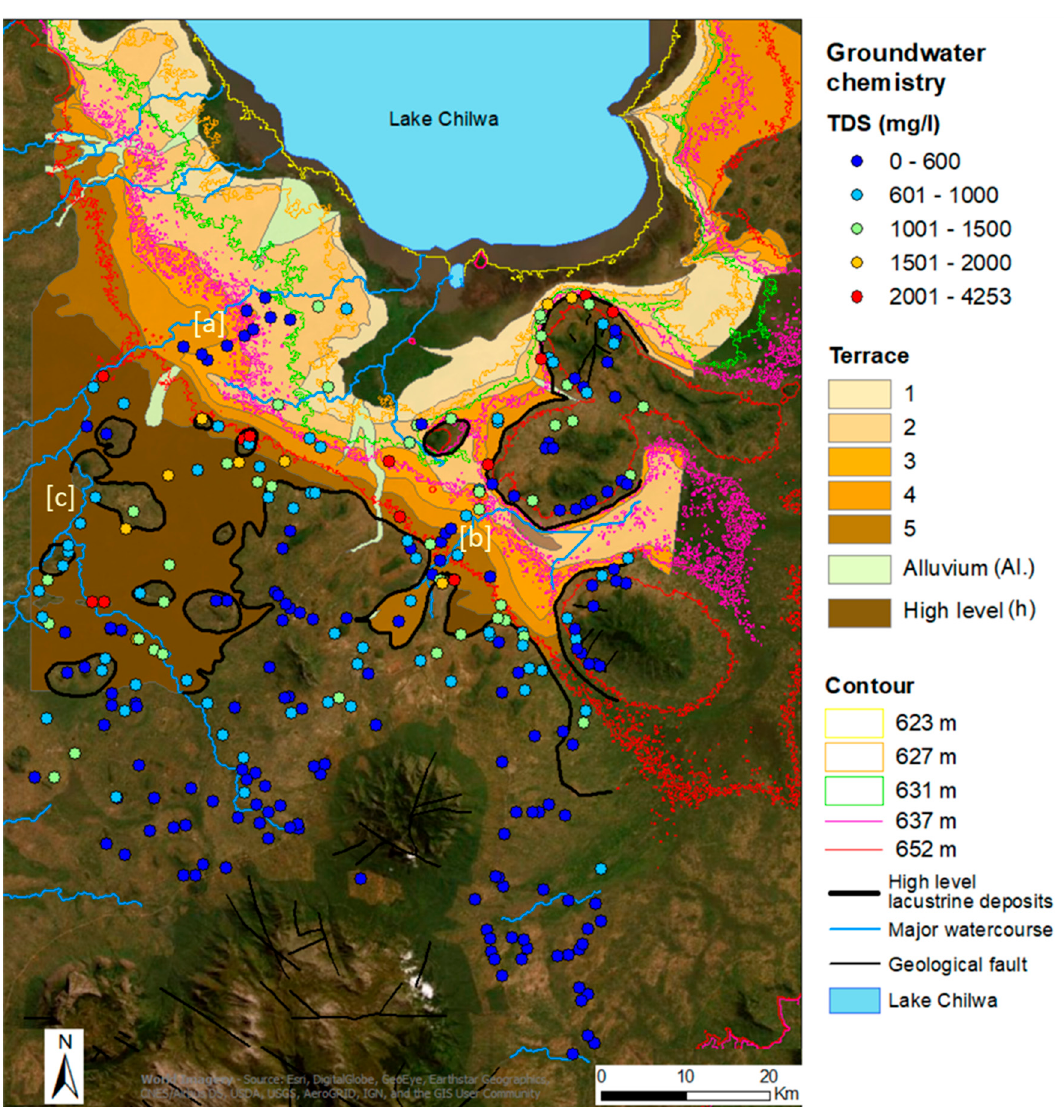
Figure 9. Phalombe District observed groundwater total dissolved solids (TDS) shown relative to a backdrop of superficial deposits and satellite ground image. Areas of possible river-reach influent seepage of low-TDS water to groundwater are labelled [a] to [c].